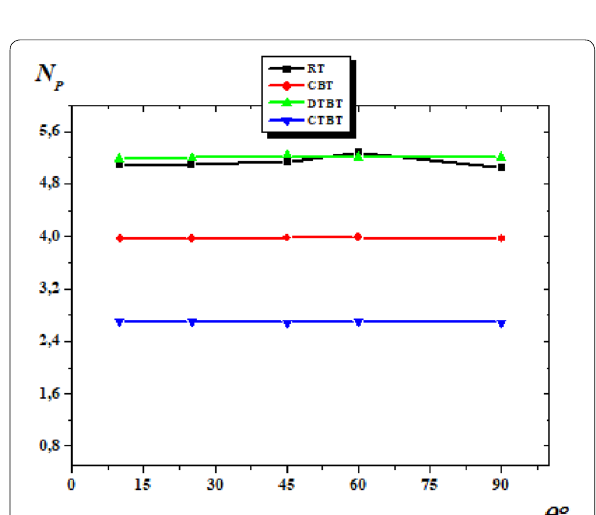
Figure 19 Power number versus impeller angles for different agitator’s types, Re